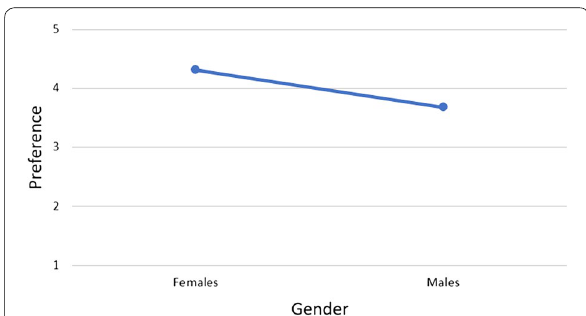
Fig. 6 Preference for open-unprotected observation points